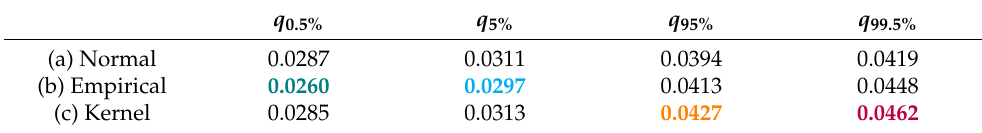
Table 2. Quantiles of cases (a), (b) and (c). The values for which it is harder to reject are coloured (the smaller values are on the left of the histogram, and the larger are on the